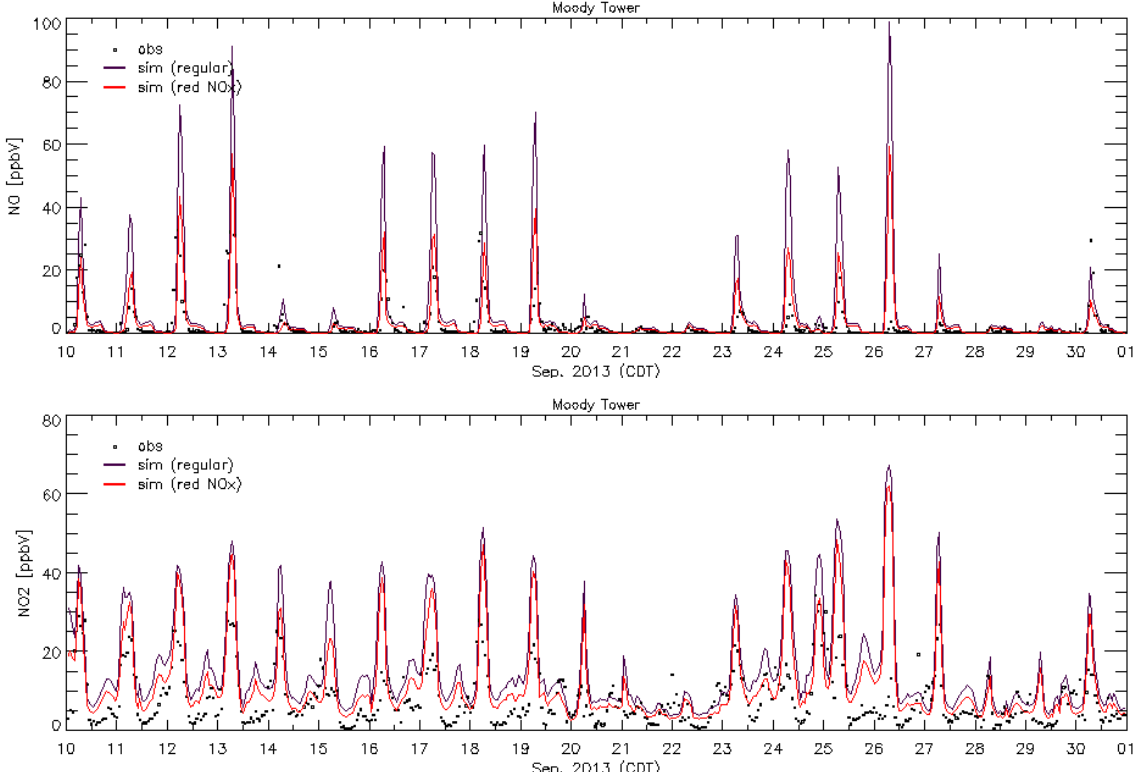
Figure 3. NO and NO 2 mixing ratio measured at the Moody Tower site and modeled with the base case emissions as well as with reduced NO x emissions.